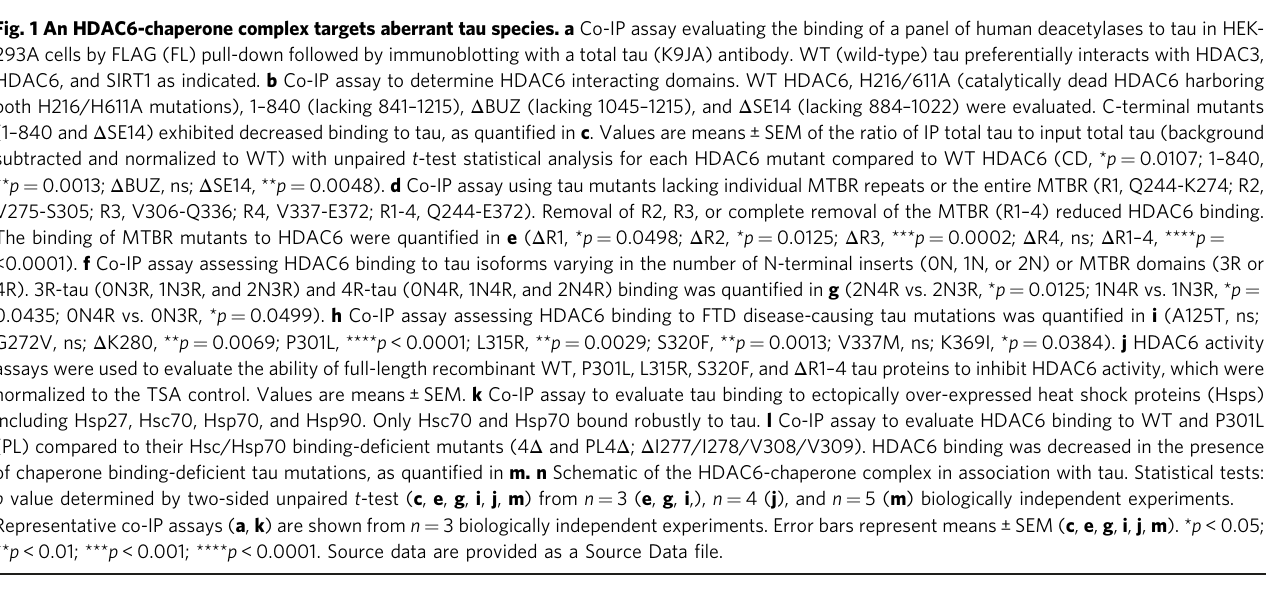
Fig. 1 An HDAC6-chaperone complex targets aberrant tau species. a Co-IP assay evaluating the binding of a panel of human deacetylases to tau in HEK- 293A cells by FLAG (FL) pull-down followed by immunoblotting with a total tau (K9JA) antibody. WT (wild-type) tau preferentially interacts with HDAC3, HDAC6, and SIRT1 as indicated. b Co-IP assay to determine HDAC6 interacting domains. WT HDAC6, H216/611A (catalytically dead HDAC6